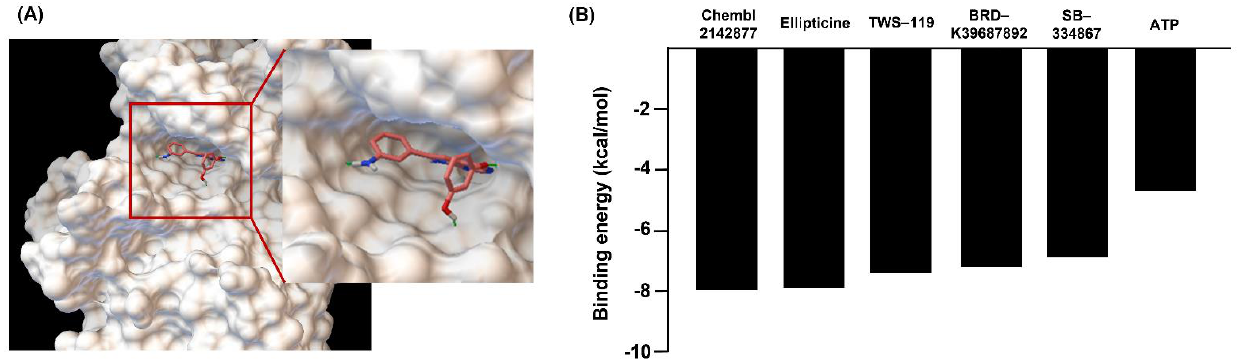
Figure 2. Results of GSK-3 β chemical docking test. Small molecules that putatively bind the binding box of GSK-3 β were identified using an in silico docking approach. We identified five small molecules that putatively bind the binding box of GSK-3 β . We conducted the binding energy calculation for the five compounds using AutoDock v.4 ( A ). Results were ranked according to the calculated binding affinity ( B ). The lowest binding affinity docking pose for ellipticine/GSK-3 β was superimposed onto the ATP/GSK-3 β crystal